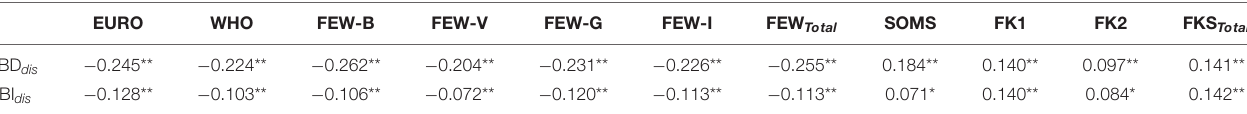
EURO WHO FEW-B FEW-V FEW-G FEW-I FEW